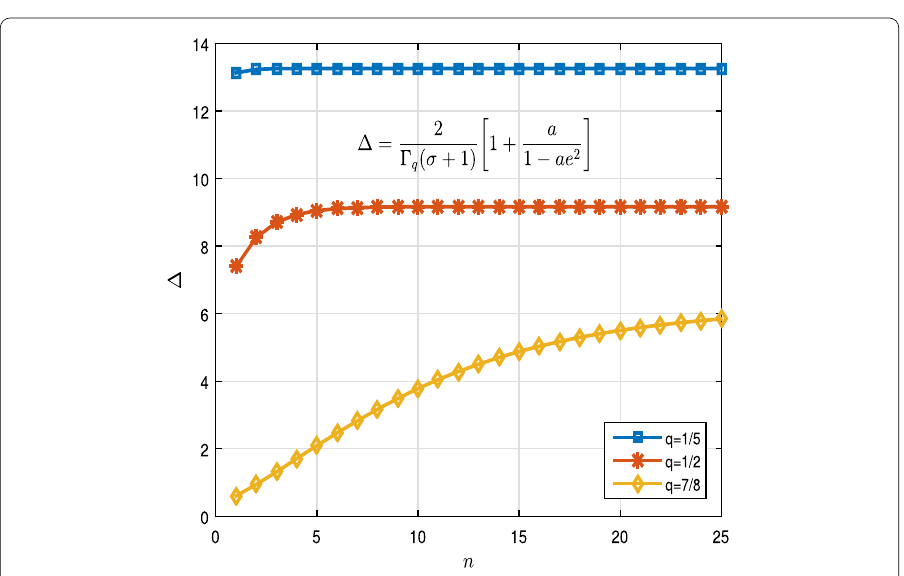
, 1 , 7 in Example 4.2 5 2 8